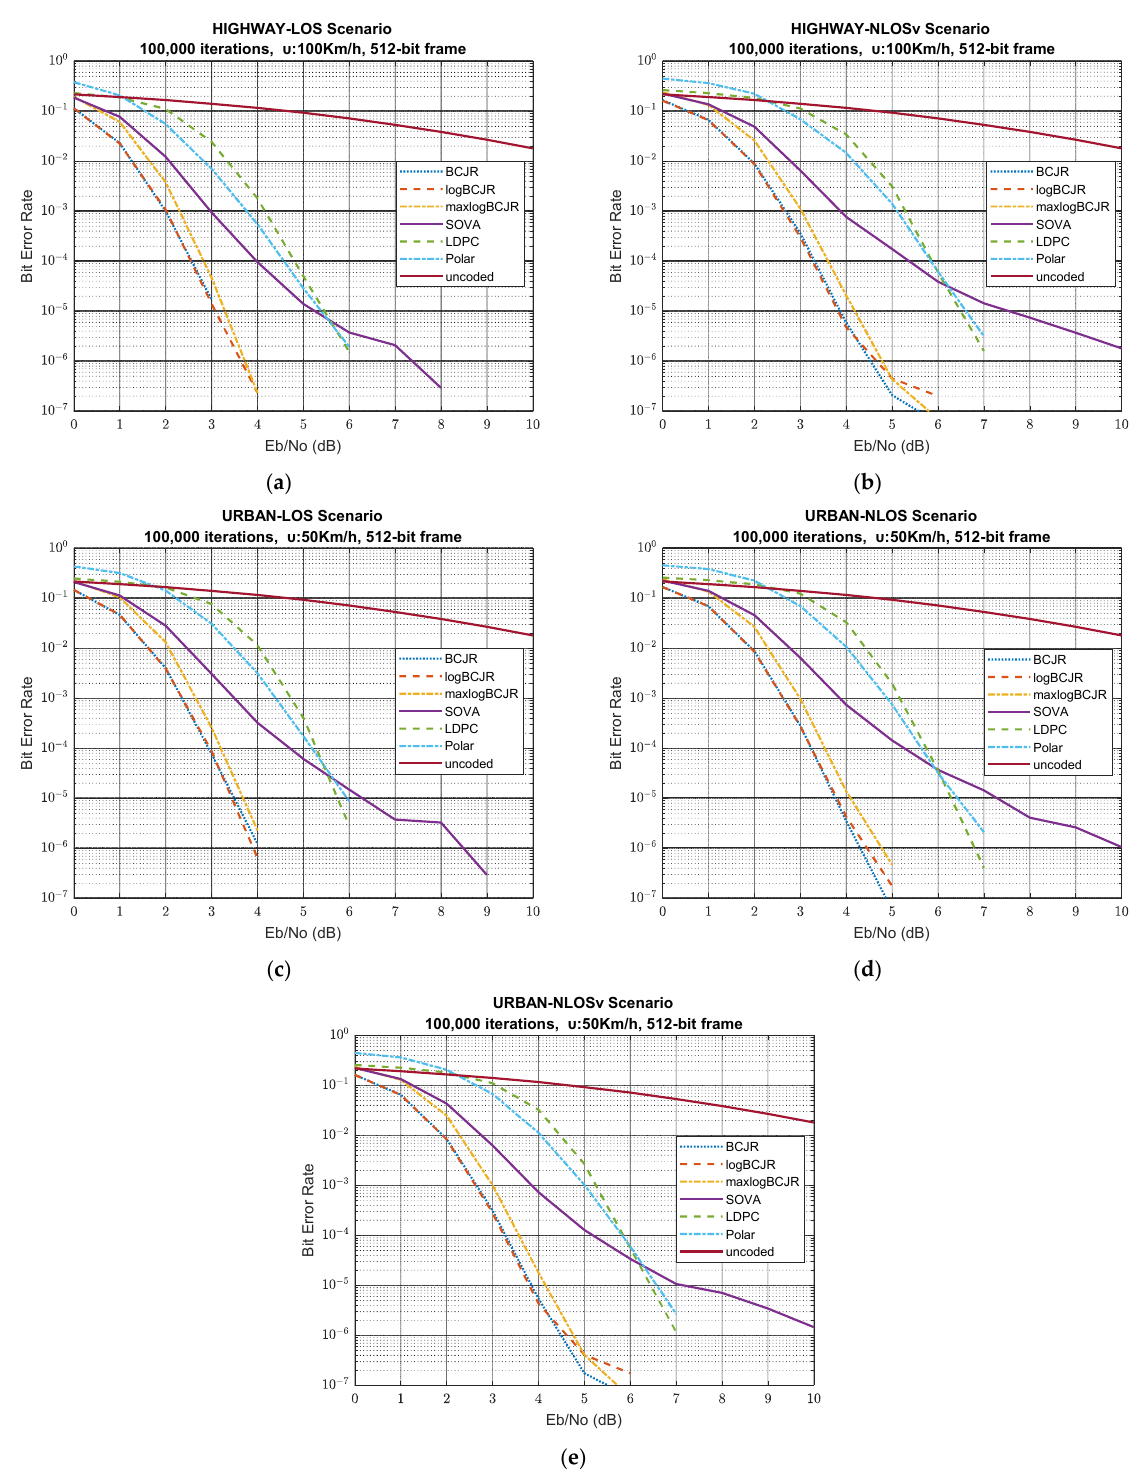
Figure 4. BER vs. SNR for scenarios 11 - 15 and 512-bit frame length. ( a ) highway - LOS scenario; ( b ) highway - NLOSv scenario; ( c ) urban - LOS scenario; ( d ) urban - NLOS scenario; ( e ) urban - NLOSv scenario.